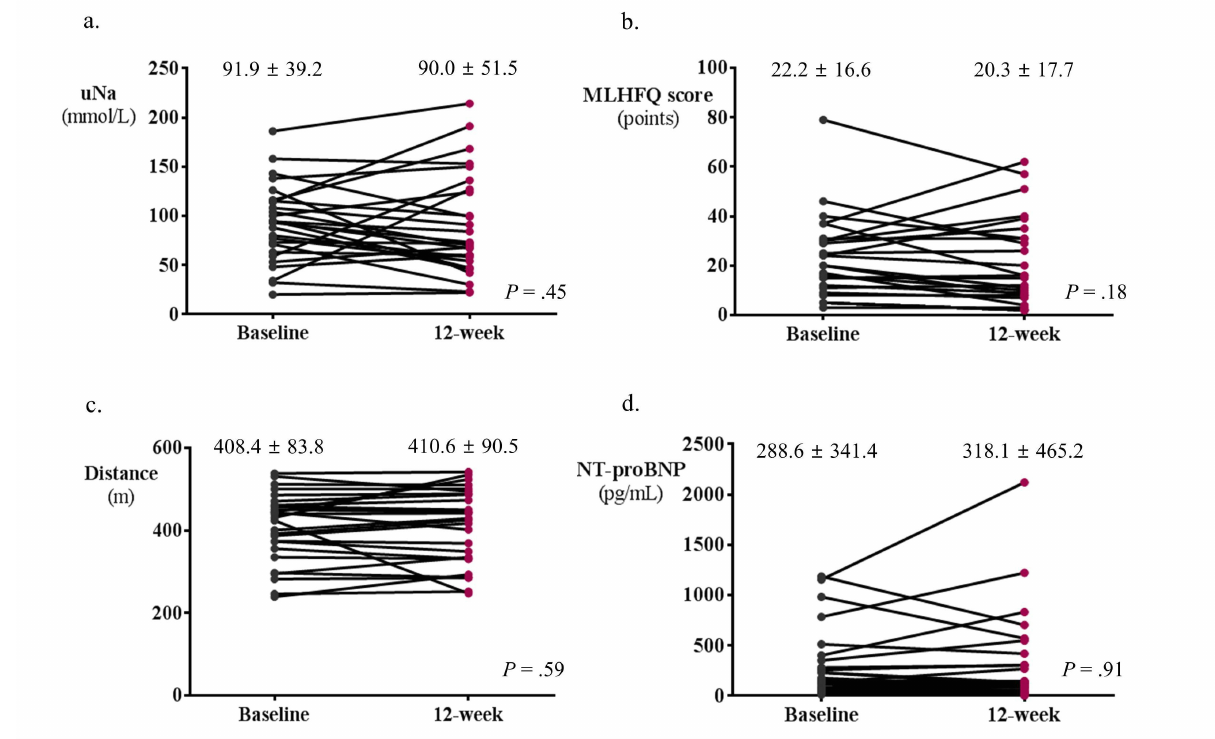
Figure 4. Changes in major outcomes over time by ICT-based telehealth program in total study population. There was no significant changes in uNa (a), MLHFQ scores (b), 6-minute walk distance (c), and NT-proBNP level (d) after 12 weeks of ICT-based telehealth program. ICT: information communication technology, HF: heart failure, NT-proBNP: N-terminal prohormone of brain natriuretic peptide, MLHFQ: Minnesota Living with Heart Failure